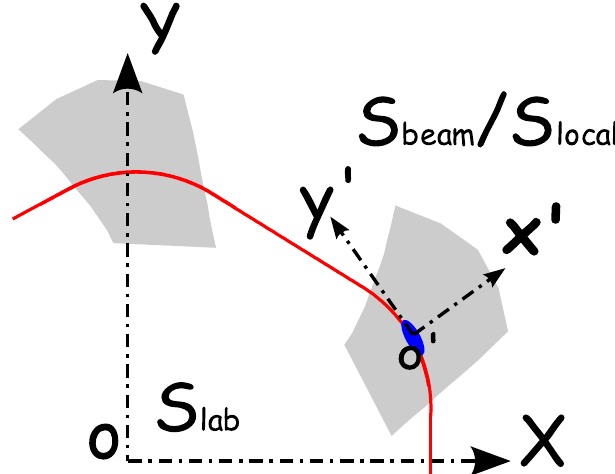
FIG. 2. (Color) Schematic plot of the top view of the three coordinates frames. The red curve is the orbit of bunch center, the blue area represents bunch shape, and the gray area is the hill region of the magnetic